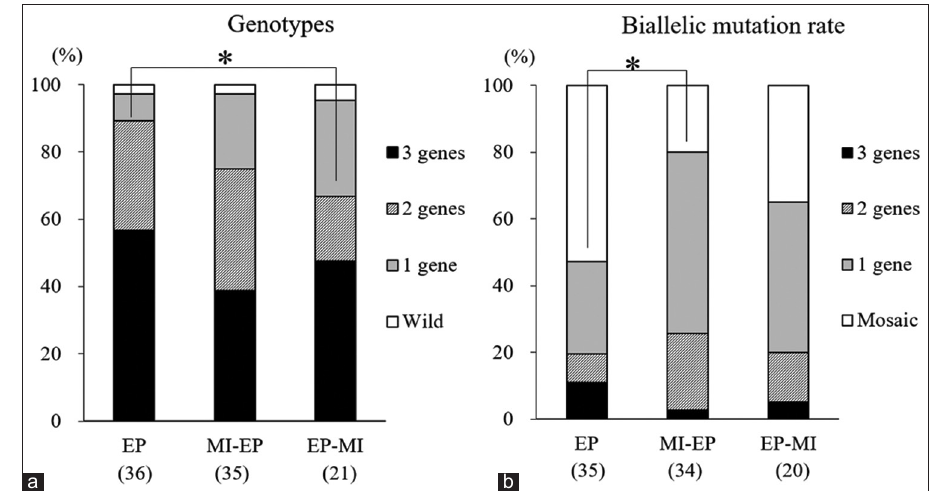
Figure-1: Introduction of the clustered regularly interspaced short palindromic repeats/Cas9 system targeting pancreatic and duodenal homeobox1 ( PDX1 ), alpha-1,3-galactosyltransferase ( GGTA1 ), and cytidine-32-monophosphate-N- acetylneuraminic acid hydroxylase ( CMAH) genes into in vitro fertilized (IVF) zygotes through electroporation (EP) alone or in combination with microinjection (MI). (a) Genotypes of blastocysts. The proportions represent the percentages of blastocysts carrying the mutation number of each target gene in the total examined blastocysts. *The rate of blastocysts with mutations in at least two target genes was significantly higher in the EP group than in the EP-MI group. p<0.05. (b) Biallelic mutations in gene-edited blastocysts. The proportions represent the percentage of biallelic mutation events in the gene-edited blastocysts. *The rate of blastocysts carrying biallelic mutations in at least one target gene was significantly higher in the MI-EP group than in the EP group. p<0.05. EP: Three guide RNAs (gRNAs) targeting PDX1 , GGTA1 , and CMAH were introduced into zygotes through EP at 10 h after the start of IVF; MI-EP: gRNA targeting PDX1 was microinjected into the zygotes 1 h before EP of two gRNAs targeting GGTA1 and CMAH ; EP-MI: gRNA targeting PDX1 was microinjected into the zygotes 1 h after the EP of two gRNAs targeting GGTA1 and CMAH . The numbers within parentheses on the X-axis indicate the total number of examined